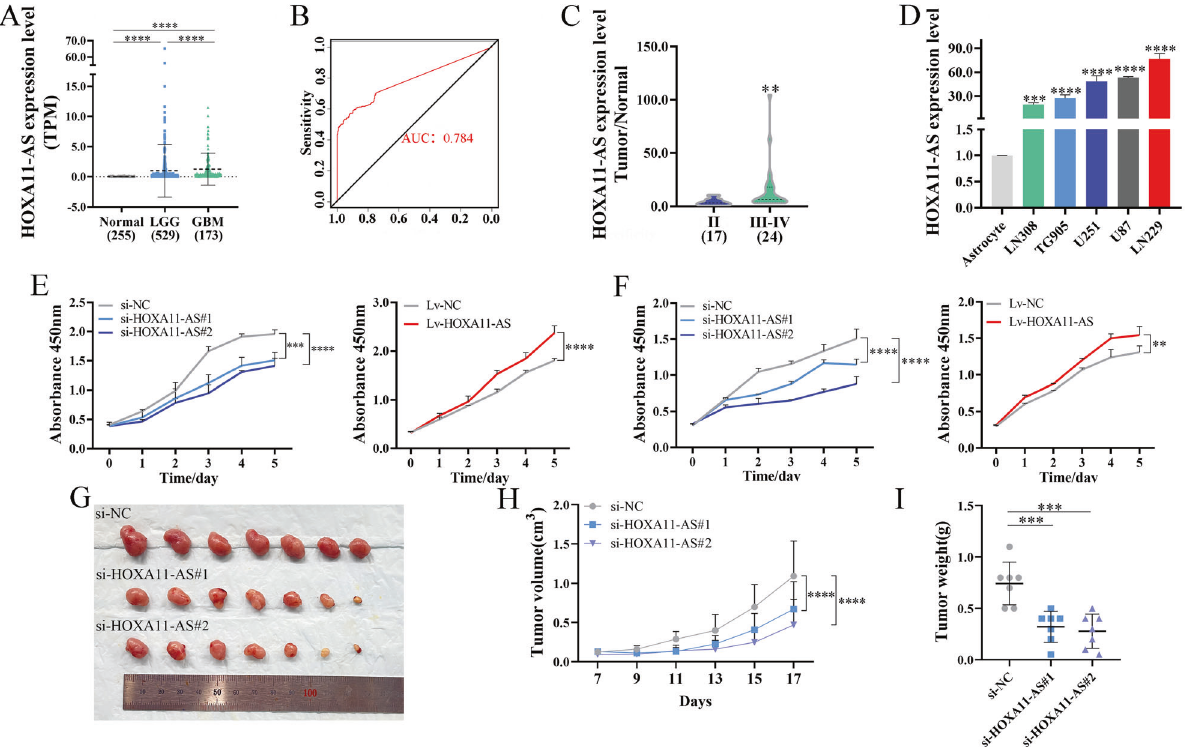
Fig. 1 Clinical features and biological functions of HOXA11-AS in glioma. A The expression levels of HOXA11-AS in normal brain tissue, LGG (WHO II-III), and GBM in TCGA and GTEx databases. B ROC curve shows the difference of HOXA11-AS expression in normal brain tissue and glioma from TCGA and GTEx databases (AUC = 0.784). C The expression levels of HOXA11-AS in 41 glioma samples, including WHO II ( n = 17) and WHO III-IV ( n = 24). D The expression levels of HOXA11-AS in astrocyte, LN308, TG905, U251, U87, and LN229 cells were veri fi ed by RT- qPCR. The effect of HOXA11-AS overexpression or knockdown on proliferation by CCK8 experiment in U87 ( E ) and LN229 cells ( F ). Xenograft mouse models were generated by subcutaneous injection of U87 cells into nude mice. Seven days after implanted, mice were treated with si- NC ( n = 7), si-HOXA11-AS#1 ( n = 7), and si-HOXA11-AS#2 ( n = 7). Representative image of dissected tumors ( G ), tumor growth curve ( H ) and tumor weight ( I ), in si-NC, si-HOXA11-AS#1 and si-HOXA11-AS#2 treated xenograft models with U87 cells. ** P < 0.01, *** P < 0.001, **** P <